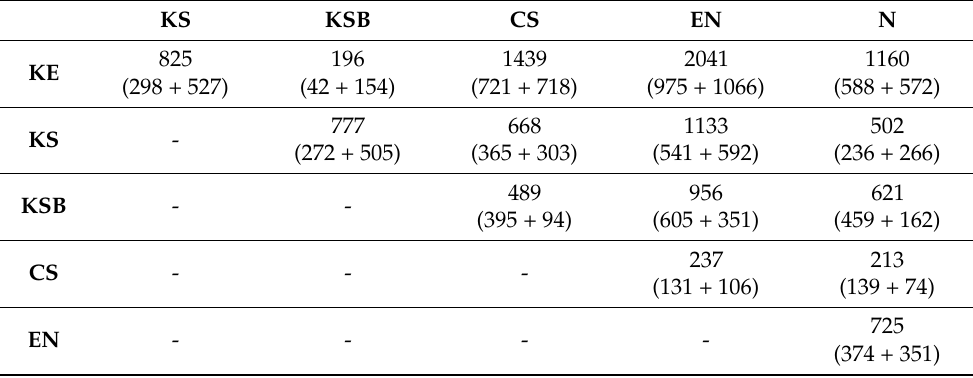
Table 3. Results of the differential expression analysis performed on each group versus each other data group, considered separately. Each cell contains the total of genes that are significantly differen- tially expressed and the partial counts of overexpressed and underexpressed).